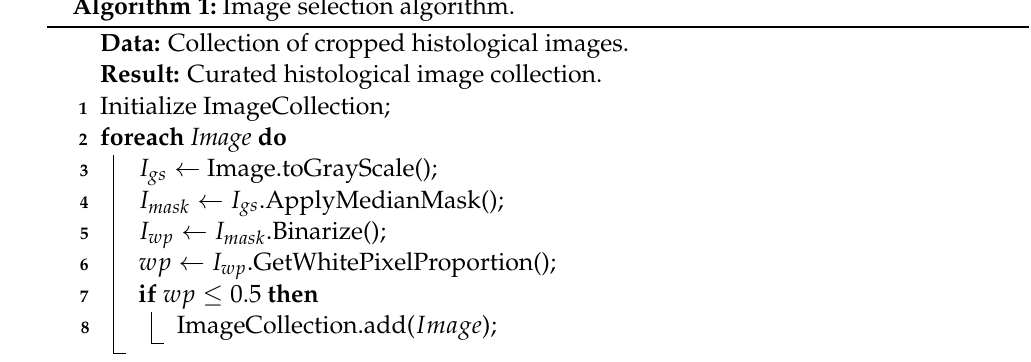
Algorithm 1: Image selection